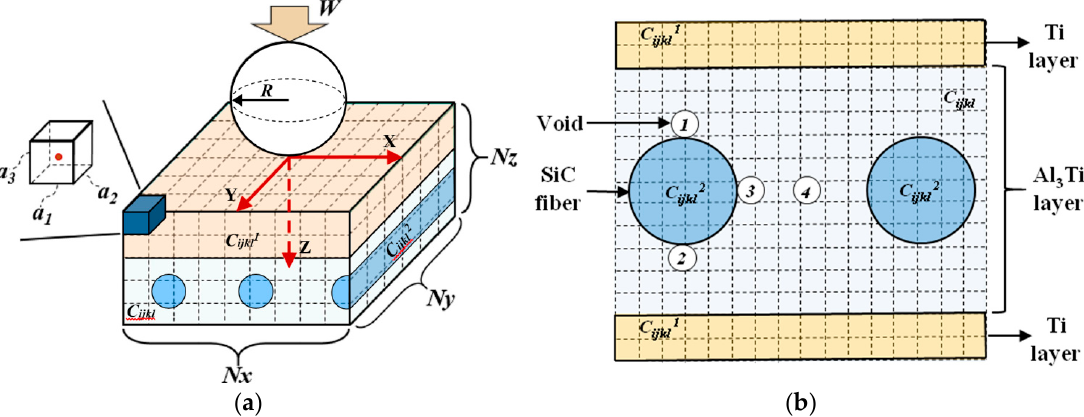
Figure 3. Schematic diagram of the semi-analytical model for the inhomogeneous material of the Ti-(SiC f /Al 3 Ti) composite: ( a ) basic contact model containing a layered inhomogeneity of Ti layer and multiple cylindrical inhomogeneities of SiC fibers [29]; ( b ) magnified cross section of the material model considering the hole defects around the SiC fibers.